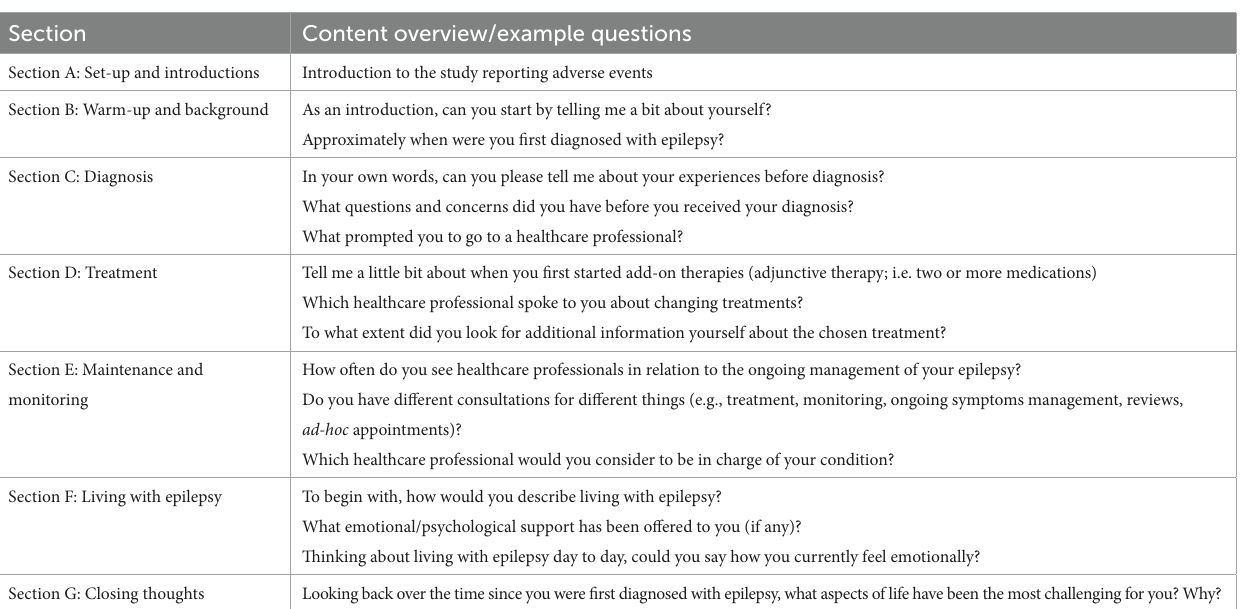
TABLE 1 Interview structure and examples of questions from the topic